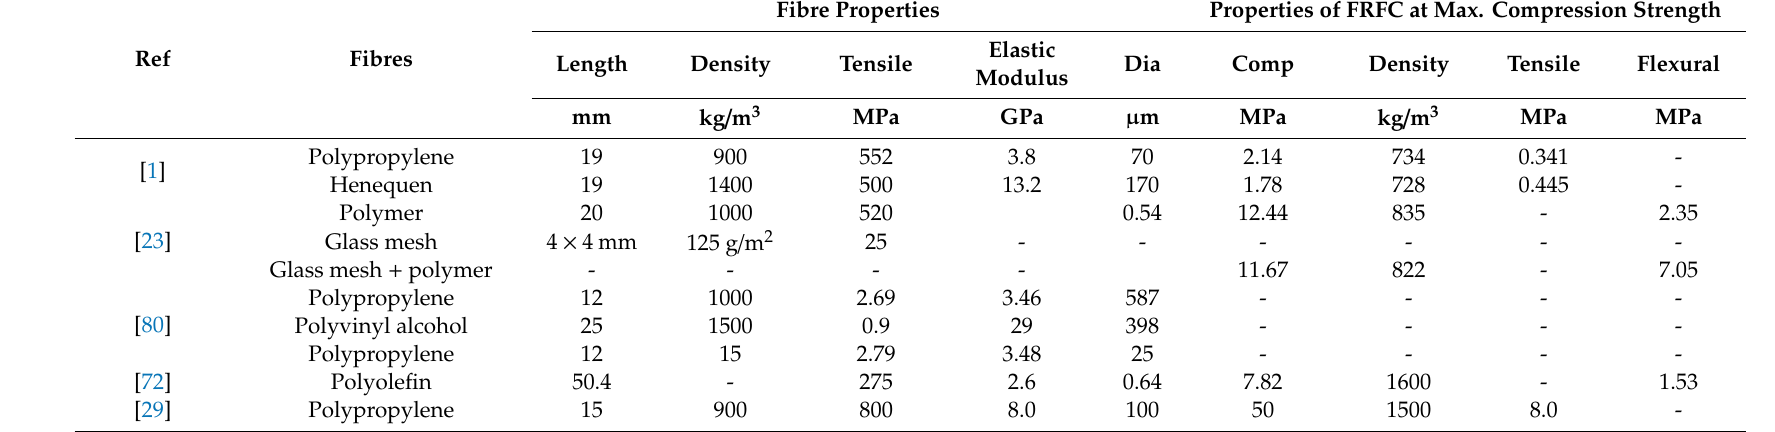
Table 4. Fibre properties from previous FRFC